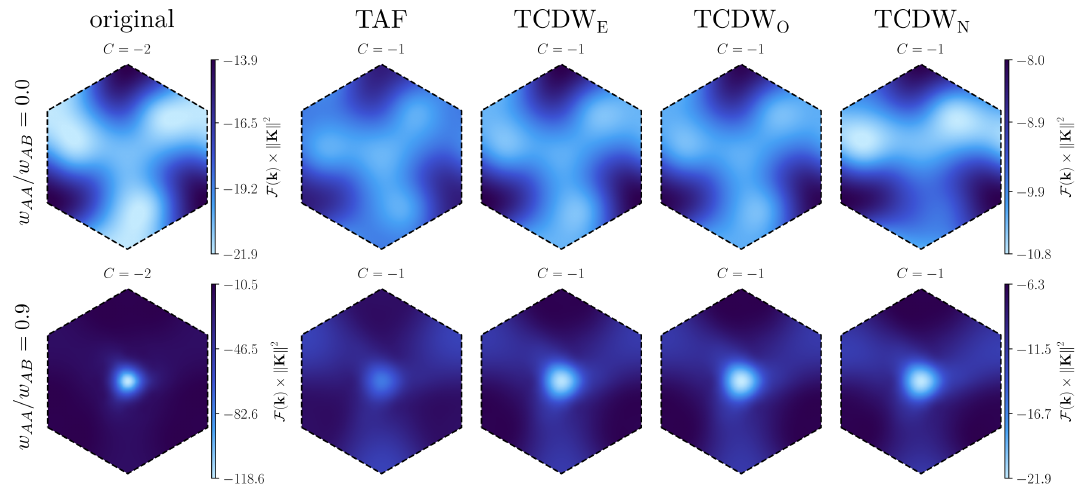
Figure 11: Folded Berry curvature to the reduced Brillouin zone of the original TDBG (ABAB) conduction band compared to those of self-consistent HF solutions at two { w representative values of w . The used cluster is AA AB